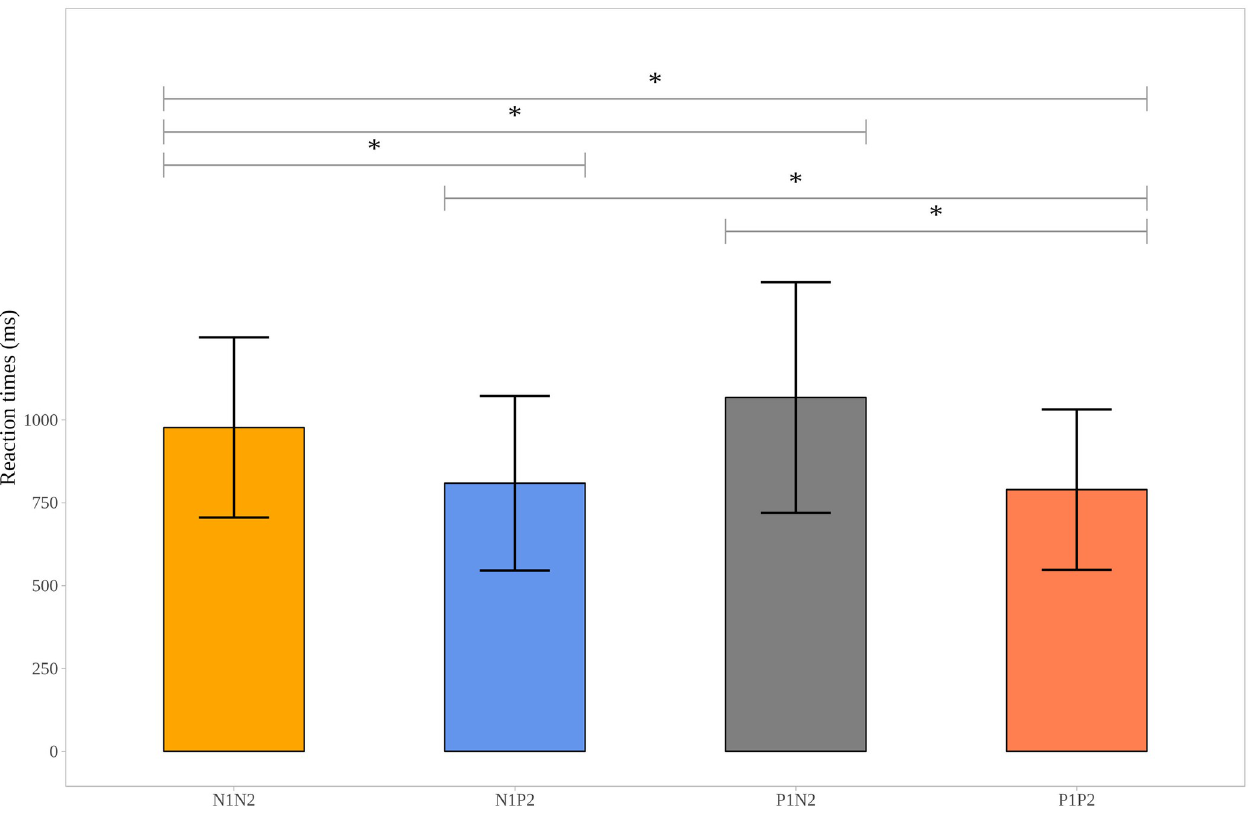
Fig 5. Mean reaction times (and standard deviations in milliseconds) to the second picture of the picture pairs in the scanner by the type of picture pairs in the Emotional Shifting Task. Note. P1: First picture of the picture pairs is positive. N1: First picture of the picture pairs is negative. P2: Second picture of the picture pairs is positive. N2: Second picture of the picture pairs is negative. � p <